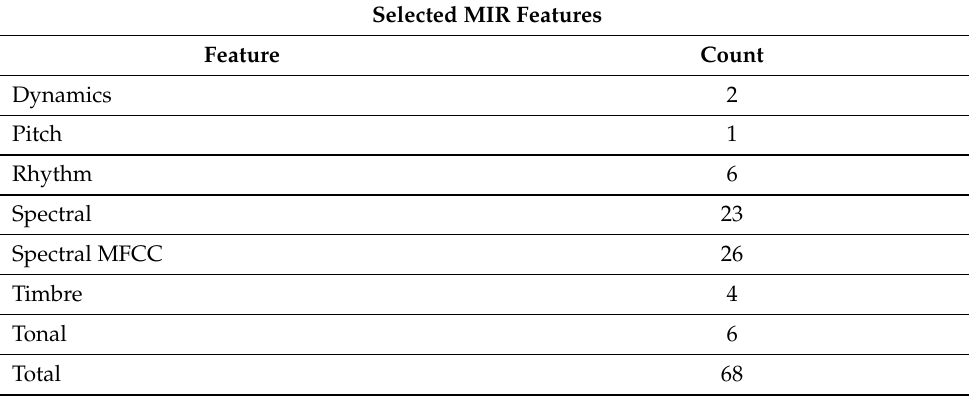
Table 3. Number of acoustic features captured by the MIRToolbox.